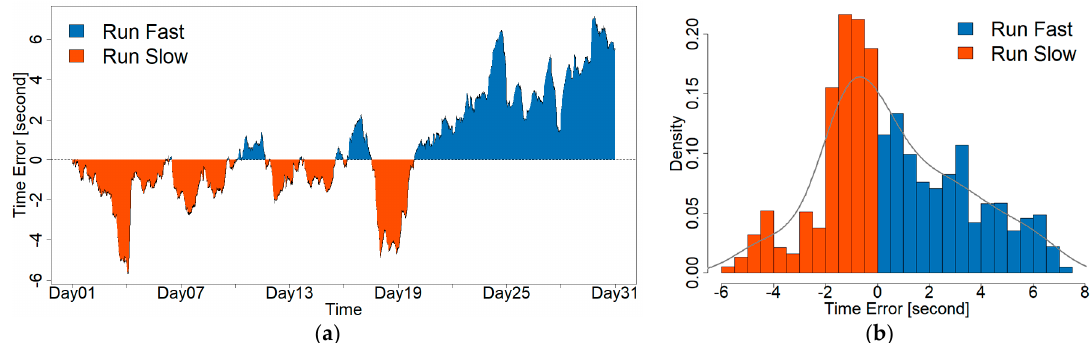
Figure 5. Time error change over one month in Electric Reliability Council of Texas (ERCOT) system of North America. ( a ) Time-series curve of the time error in October 2016; ( b ) Probabilistic distribution function of time error over one month. The blue color indicates the fast time error. The orange color presents the slow time error. The grey line shows the estimated probability density of time error.